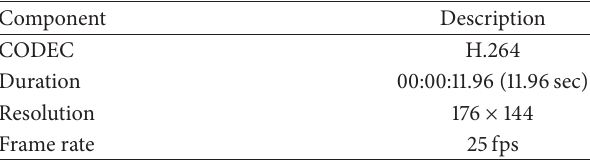
Table 4: Content specification.